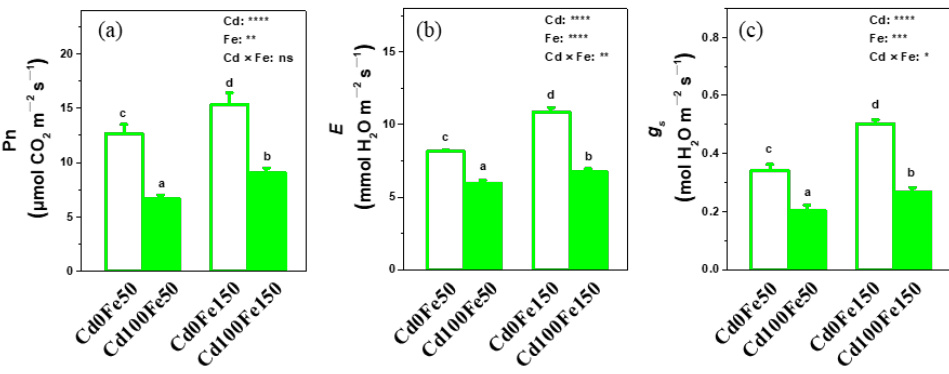
Figure 4. The Pn ( a ), E ( b ) and g s ( c ) of poplar under different Cd and Fe combined treatments. Data were means ± SE (n = 6). Different lowercase letters on the bars indicate significant differences in ANOVA ( p < 0.05). p values of two-way ANOVA on Cd, Fe, and their interaction (Cd × Fe) were indicated (*, p < 0.05; **, p < 0.01; ***, p < 0.001; ****, p < 0.0001; ns, not significant).